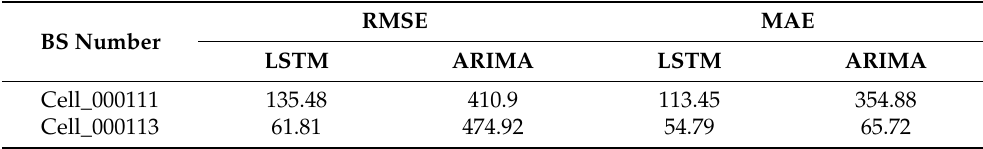
Figure 9. Traffic prediction error of base station Cell_000113. Table 2. Comparing the prediction effect of two models.